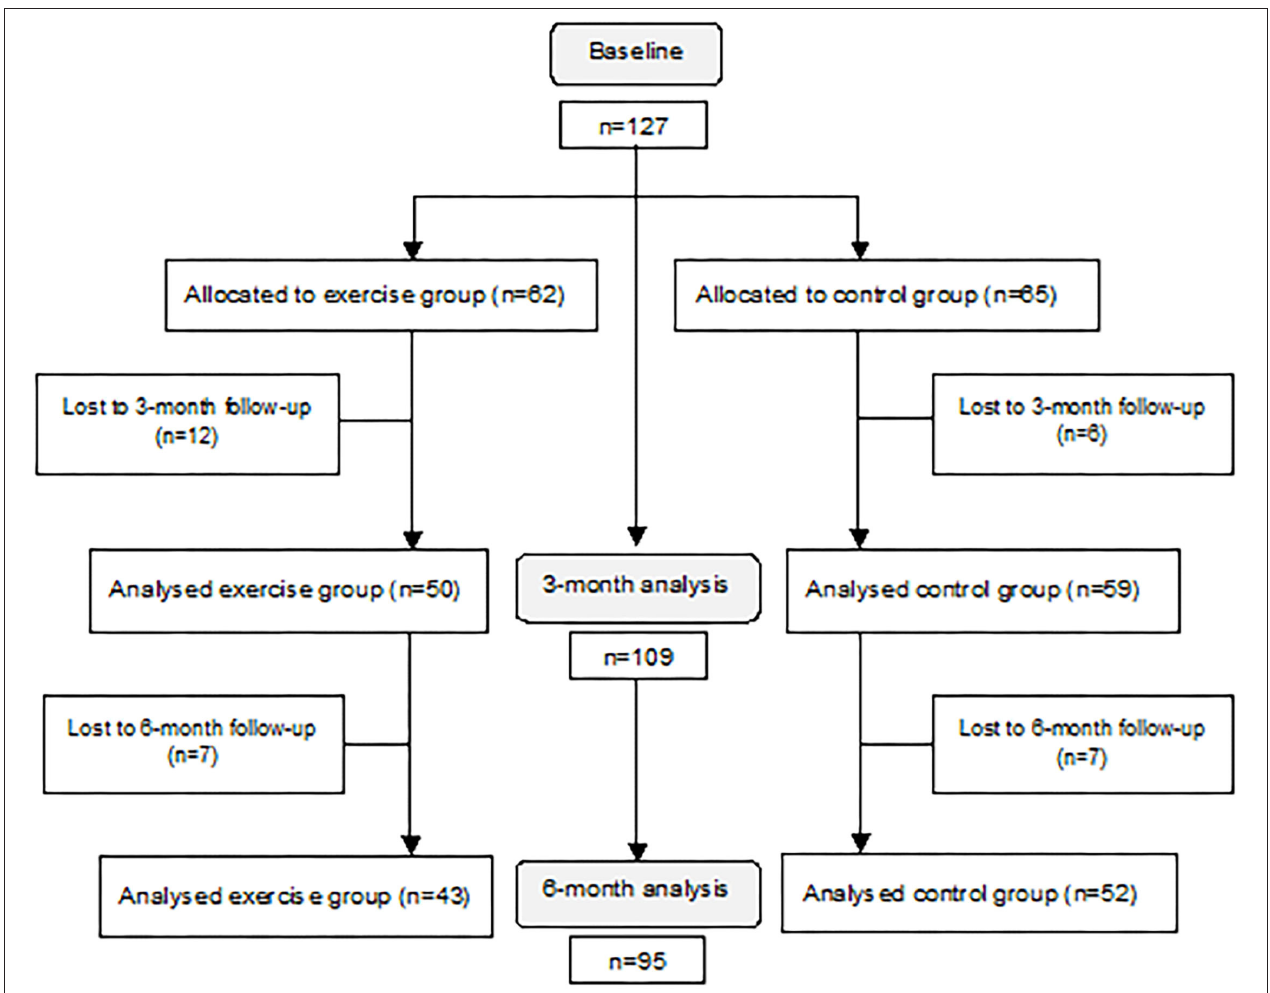
FIGURE 1 | A flowchart of the inclusion and follow-up process, including dropouts.